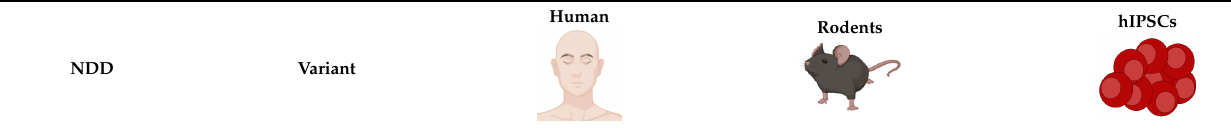
Table 3. Described ASD human, rodent and hIPSCs phenotypes. Table 4. Described MECP2 mutations in human, rodent and hIPSCs phenotypes.